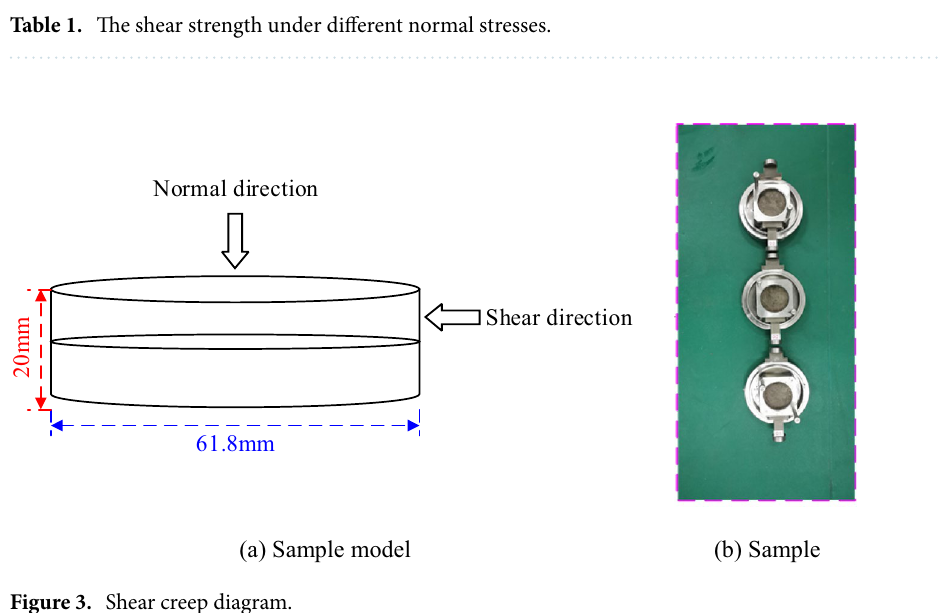
Figure 3. Shear creep